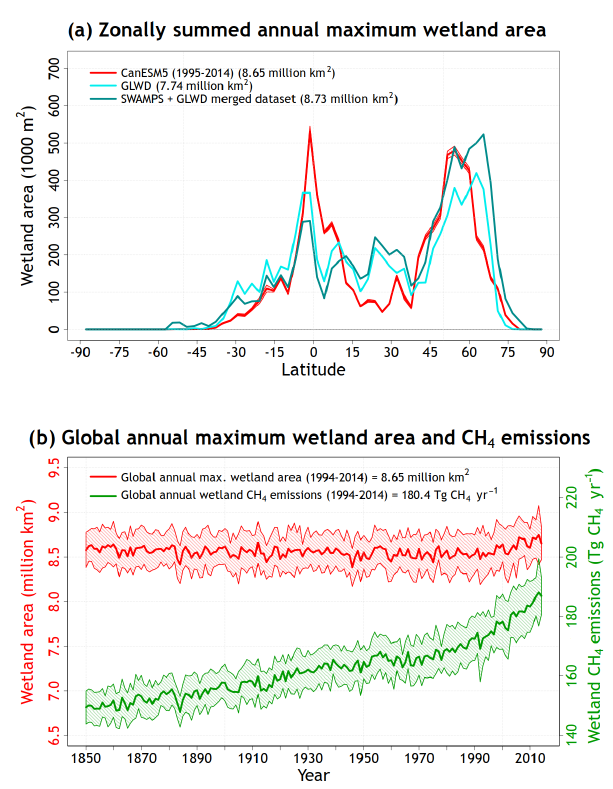
Figure G1. Comparison of simulated zonally summed annual max- imum wetland area with observation-based estimates based on the Global Lakes and Wetland (GLWD; Lehner and Döll, 2004) and a new product that is formed by merging remote-sensing-based ob- servations of daily surface inundation from the Surface Water Mi- crowave Product Series (SWAMPS; Schroeder et al., 2015) with the static inventory of wetland area from the GLWD as explained in Poulter et al. (2017) (a) . Panel (b) shows the temporal evolution of simulated global annual maximum wetland extent and wetland methane emissions over the 1850–2014 period of the historical sim-